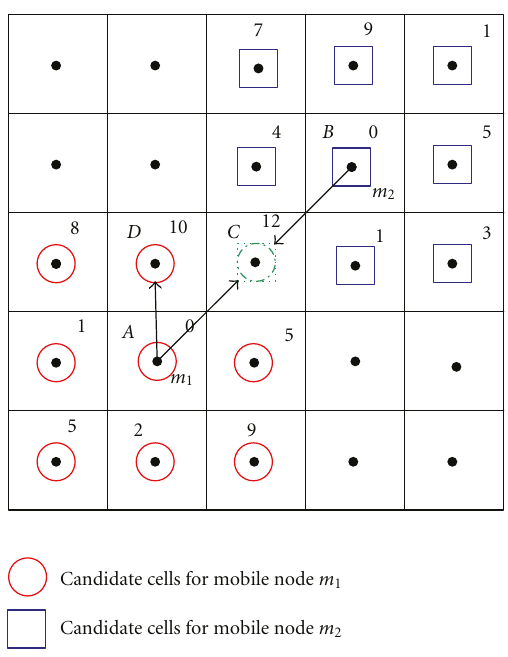
Figure 5: Duplicate covering at a given